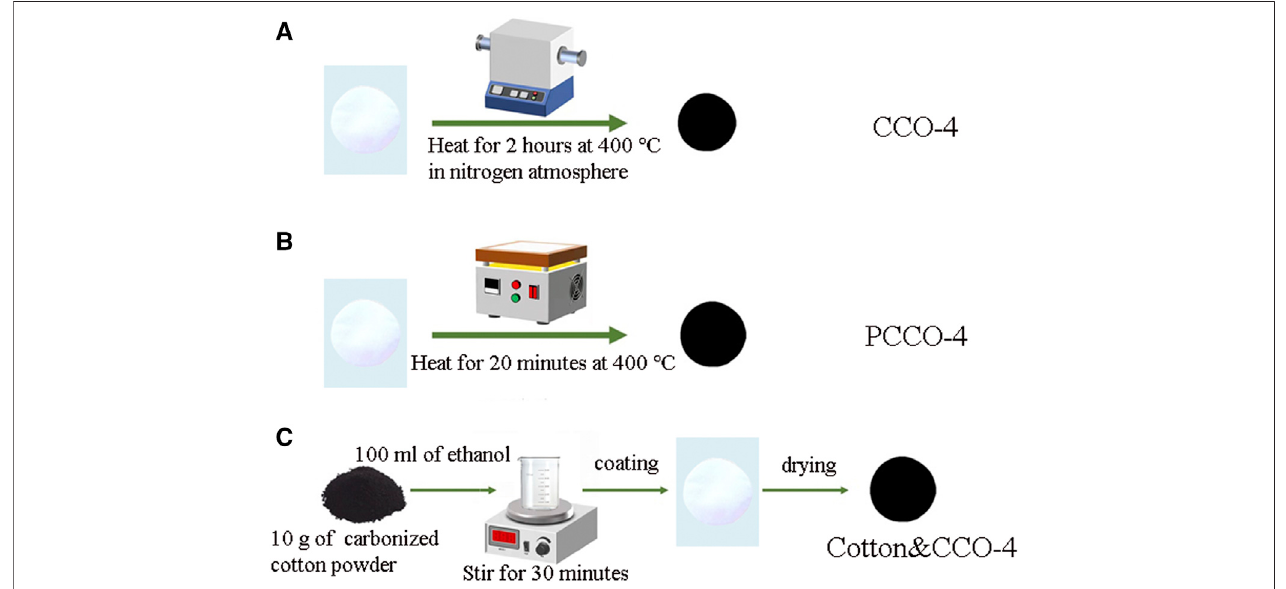
FIGURE 1 | Schematic diagram of preparation of three cotton-based carbon materials: (A) pyrolysis in a tube furnace at 400 ° C, (B) contact carbonization of a heated plate at 400 ° C, and (C) solution deposition of carbonized cotton powder on untreated cotton.